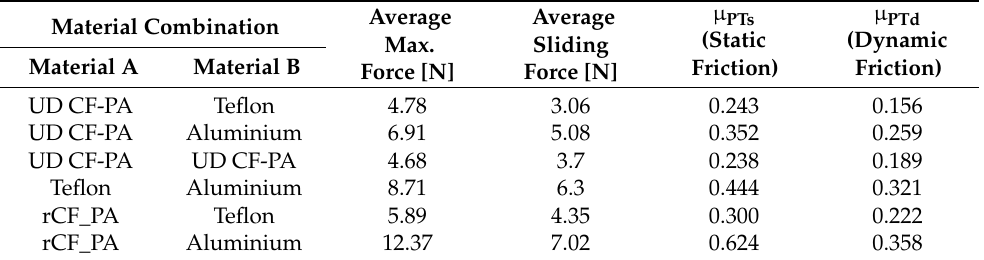
80 mm. All tests were performed at room temperature. The load-displacement data were recorded for three replicates, where only material A was replaced by a new one after each examination. To calculate the friction coefficients, two forces were evaluated from the load-displacement curves. The static and dynamic coefficients of friction were calculated according to Equation (1), where µ PT is the coefficient of friction, F is the recorded force, F N is the applied normal force, m is the mass and g the gravitational acceleration. Table 2. Overview of the material combinations, the measured forces and calculated friction values. Material Combination